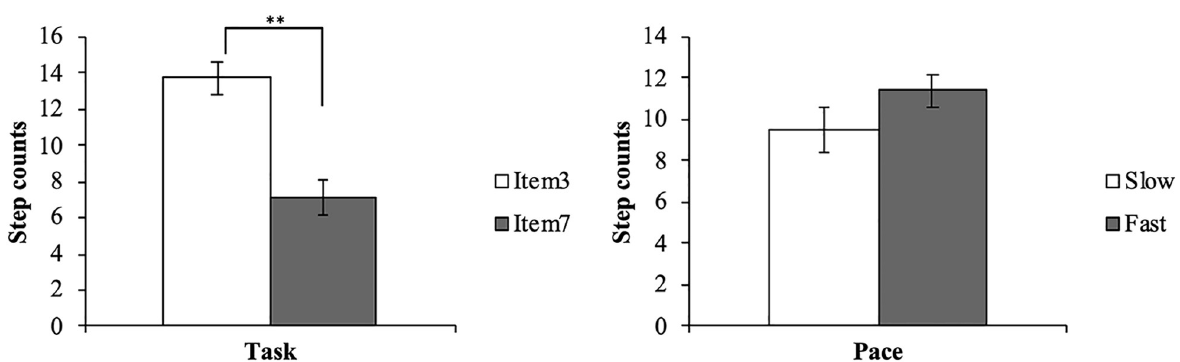
Fig 6. tTask effect for step counts of Flex2. Step counts represent the average step counts measured by Flex2, �� p < 0 . 01 , � p < 0 . 05 .